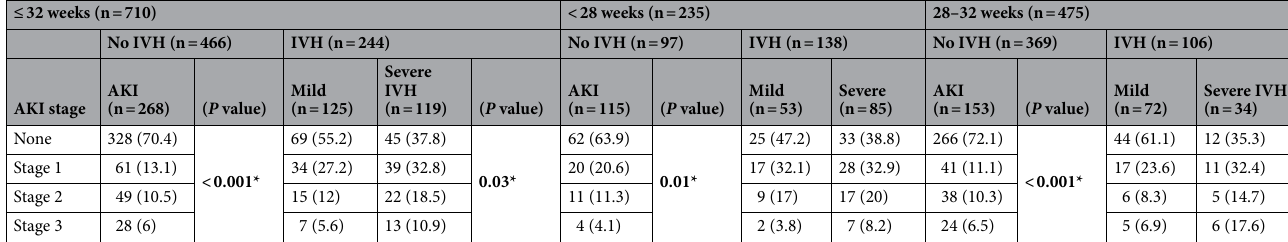
Table 2. Association between AKI stages and IVH grades (n = 710). Abbreviations: IVH intraventricular hemorrhage, AKI acute kidney injury. *Statistically significant at 5% level. Bold values indicate all values less than 0.05 are